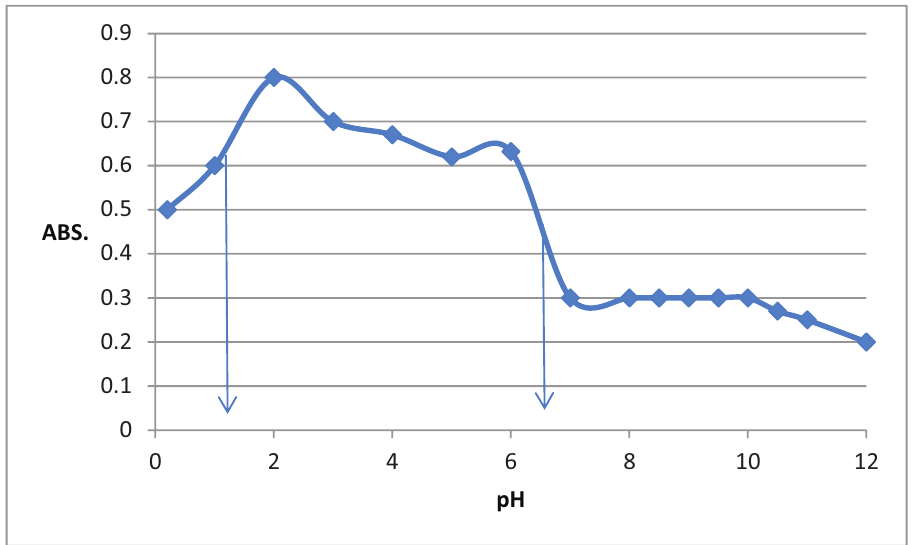
Figure 15: The absorbance–pH plot of